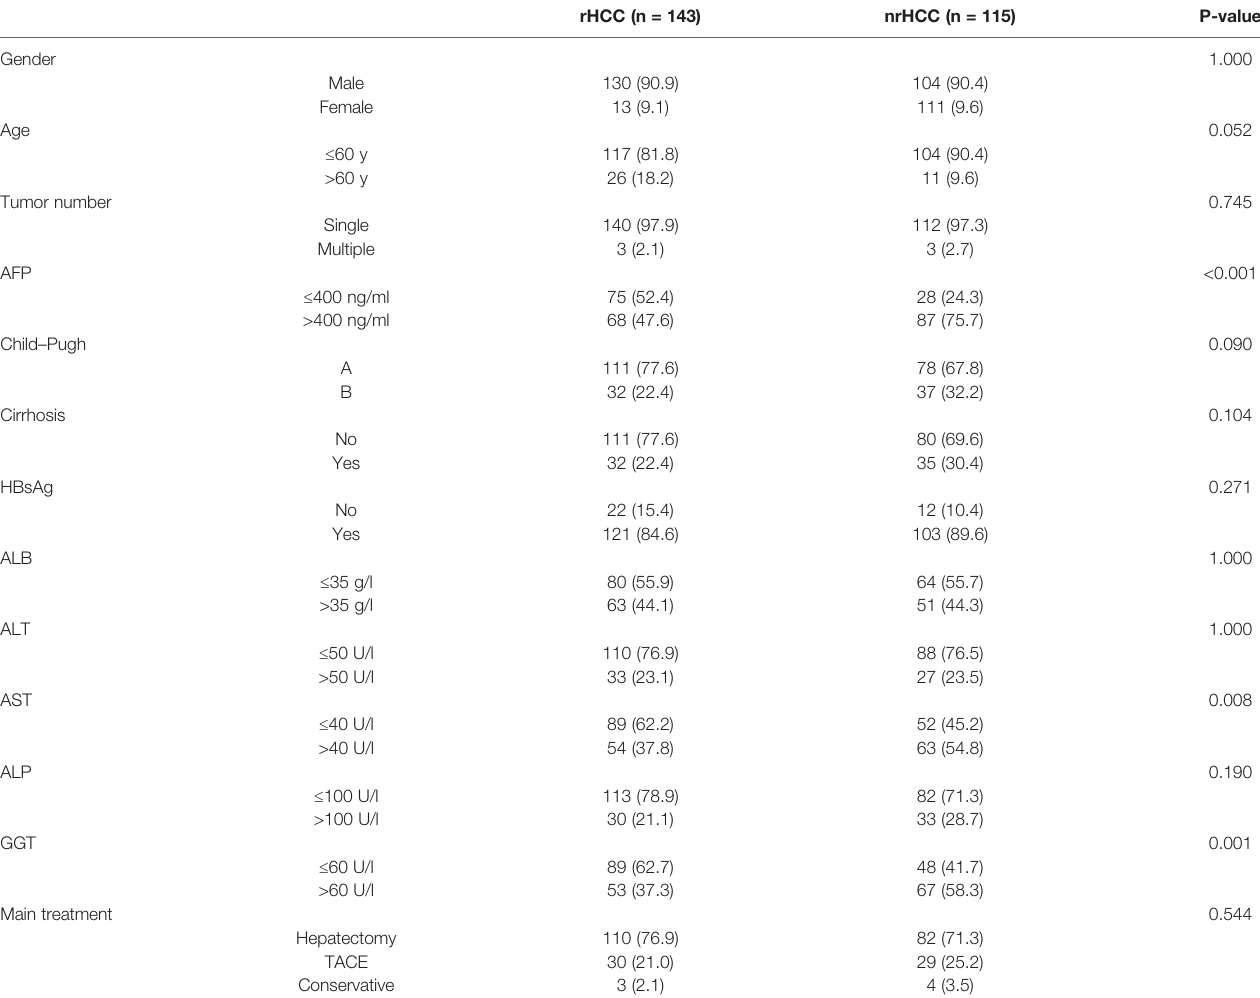
TABLE 3 | Baseline characteristics of nrHCC and rHCC patients in BCLC 0/A stage (n=258).